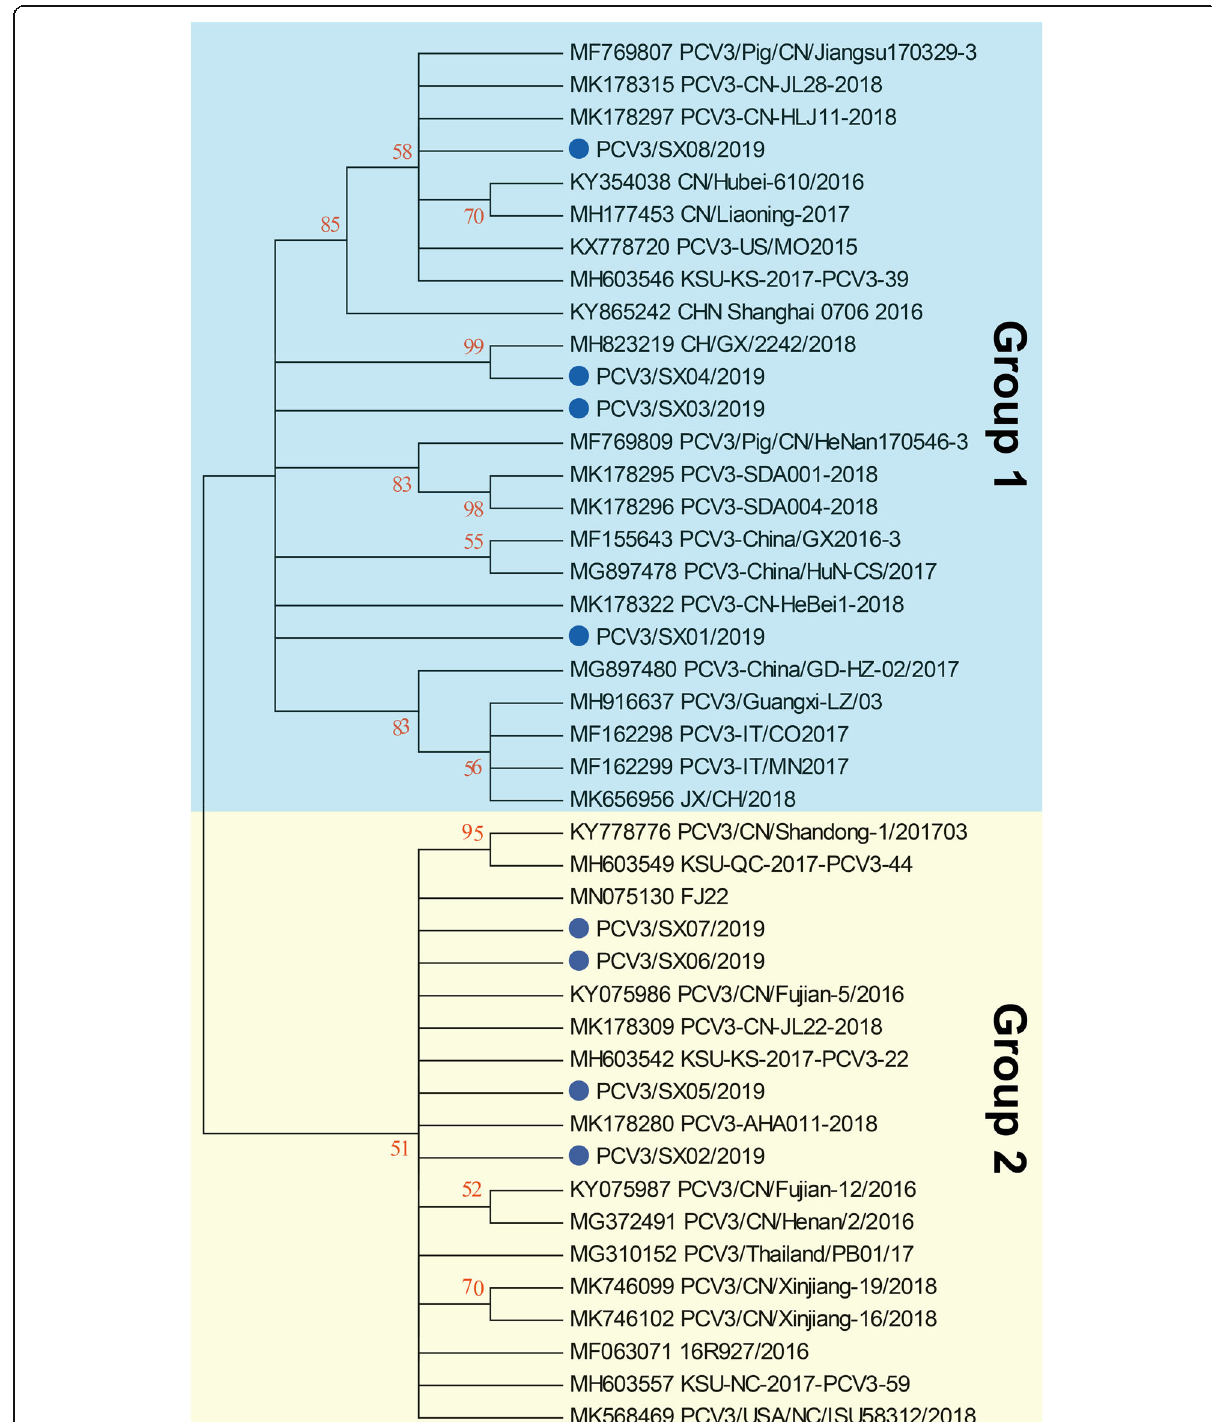
Fig. 3 Phylogenetic tree of ORF2 of porcine circovirus type 3 (PCV3). Blue dots indicate PCV3 strains investigated in this